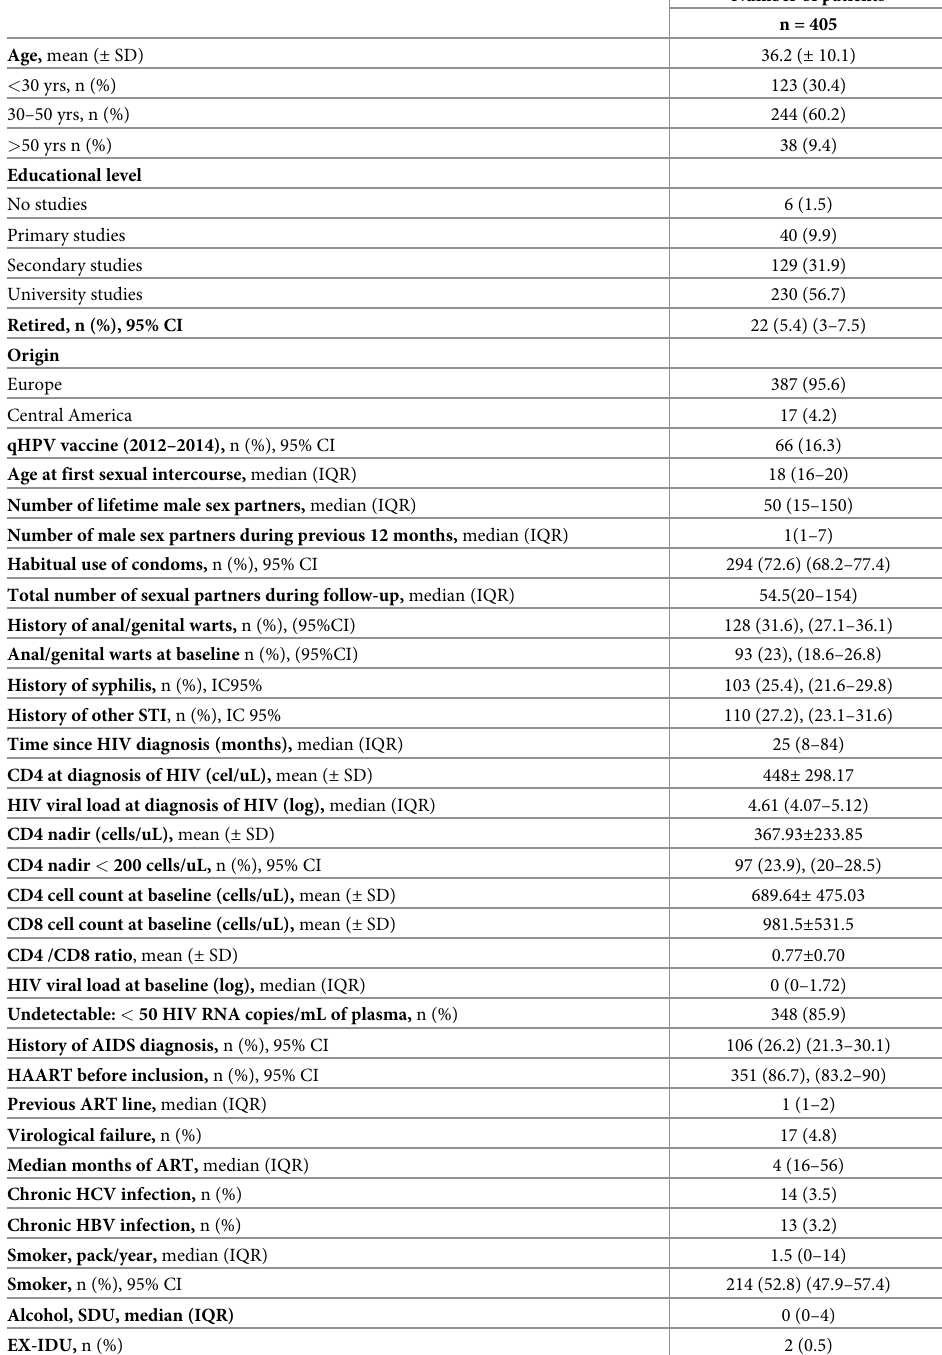
Table 1. Characteristics of HIV-infected MSM